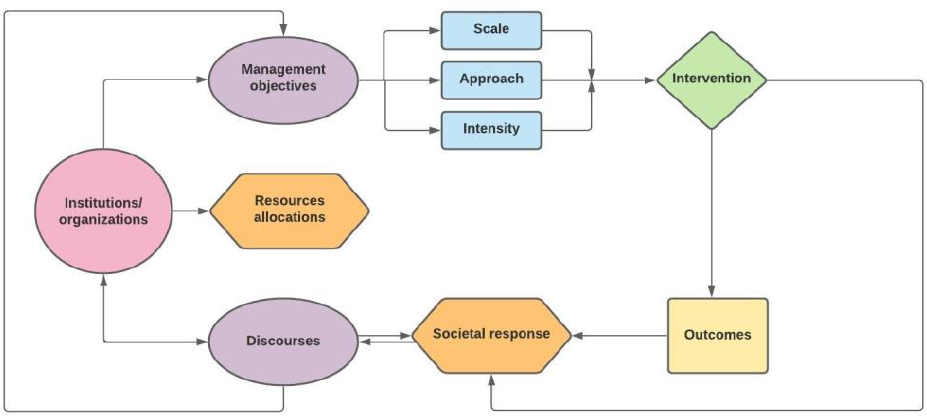
Figure 1. Framing forest health .